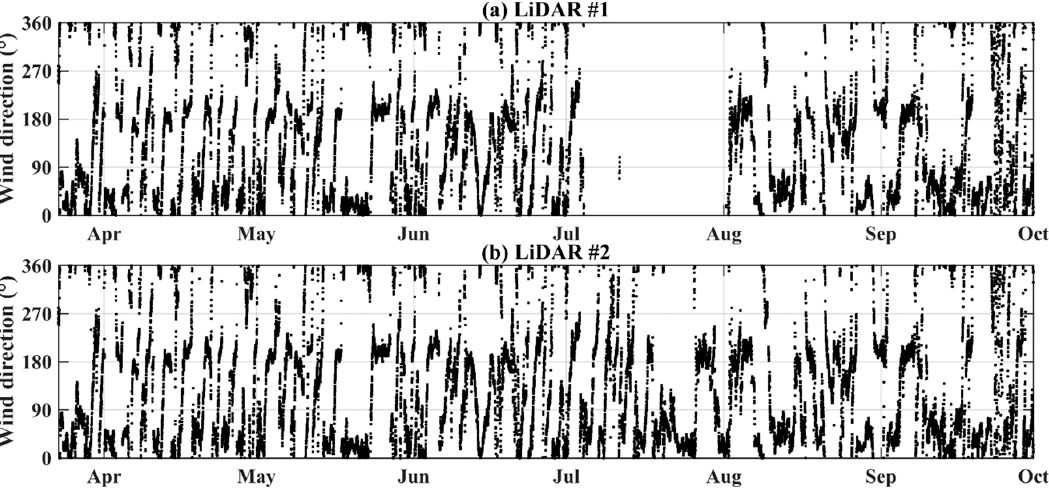
Figure 6. Same as Figure 5, but for wind directions.